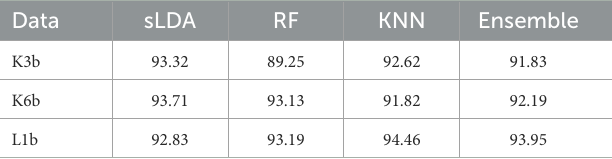
TABLE 3 The classification accuracy of different classifiers on dataset IIIa. TABLE 4 The classification accuracy of different classifiers on dataset